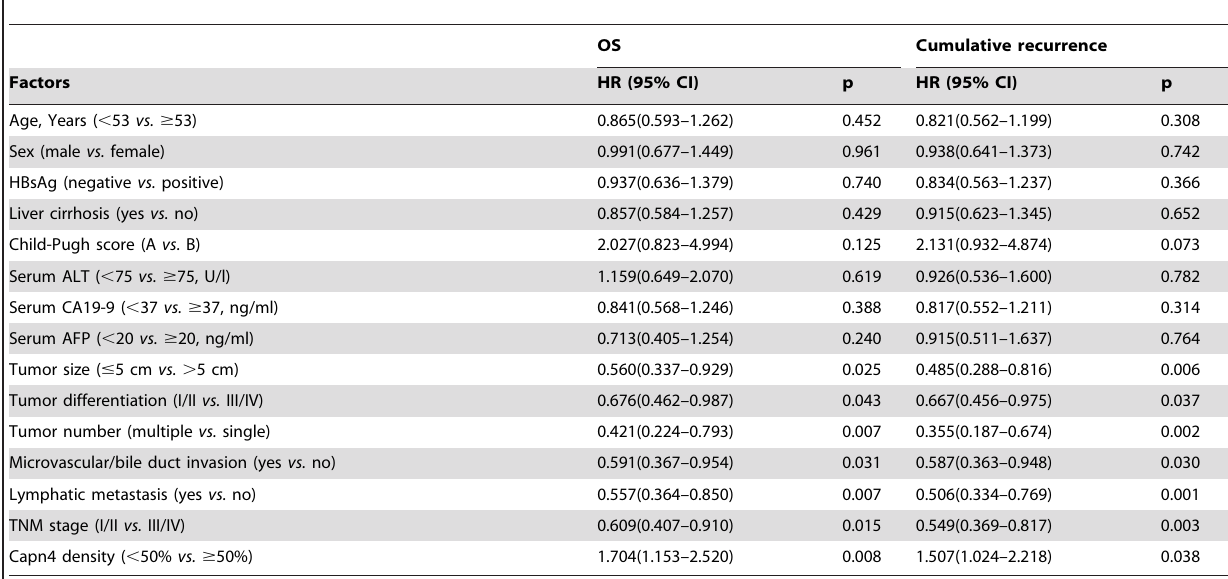
Table 2. Univariate analysis of factors associated with survival and